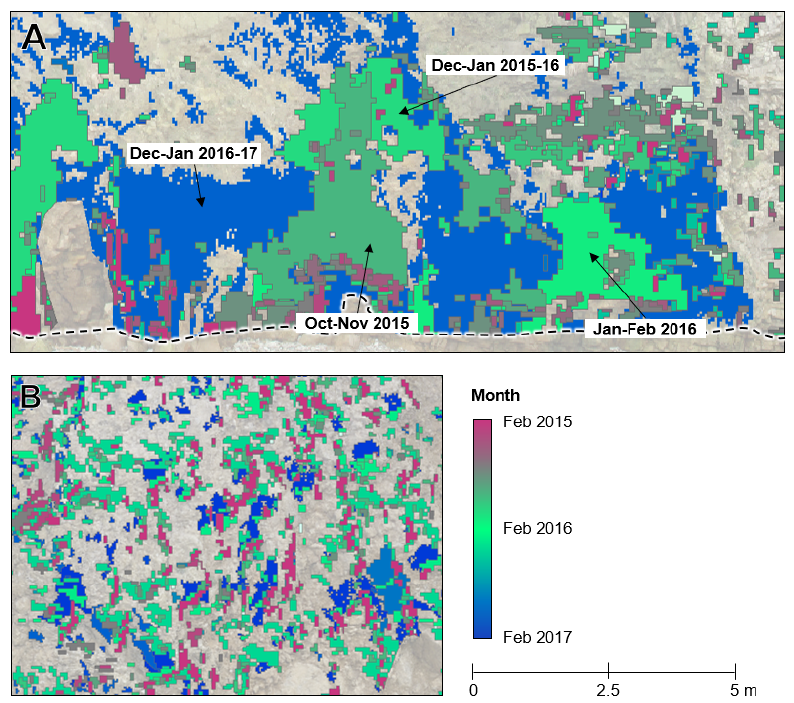
Figure 9. Progressive rockfall development over a two-year period. ( A ): Progressive failure evolution at the cliff base, in this case, via the expansion of marine erosion-undercutting. Through time, intersecting rockfalls progressively increase in size, culminating in scar coalescence and large-scale failure (e.g., Dec–Jan 2016–17). ( B ): A sub-region of the highly fragmented brecciated limestone, where progressive rockfalls account for 50% and 77% of rockfalls by frequency and eroded volume, respectively. The dashed line in A shows the minimum common vertical extent of overlapping scans due to fluctuations in beach surface height at the cliff toe (local mean 0.3 m). See Figure 3 for locations.